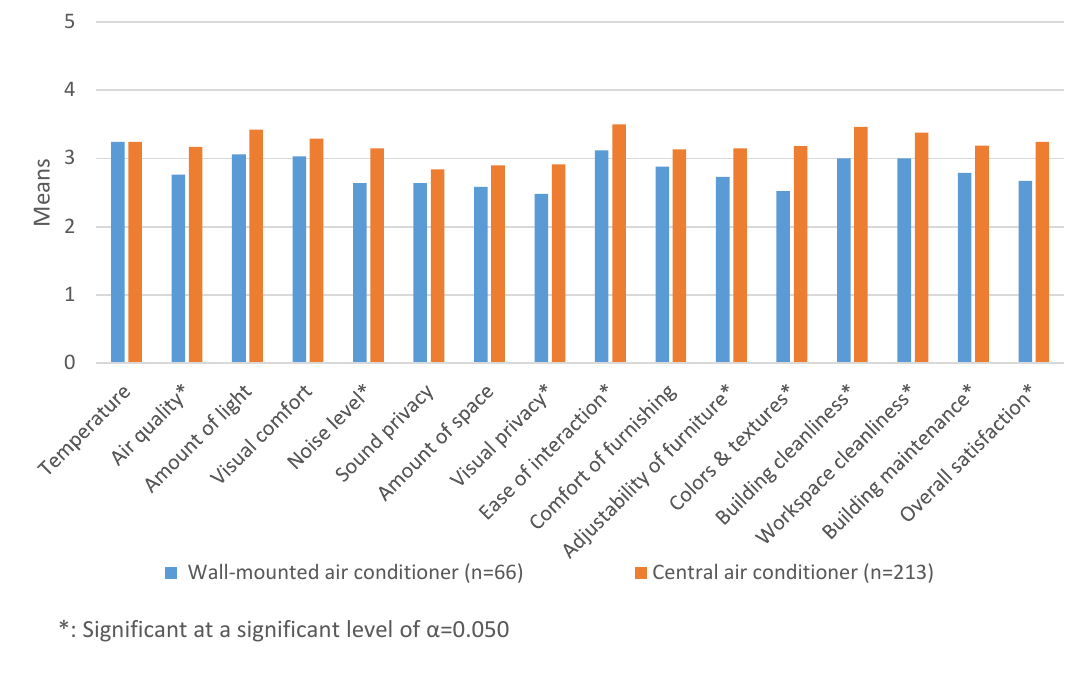
Figure 9. The impact of ventilation system on satisfaction with IEQ factors.